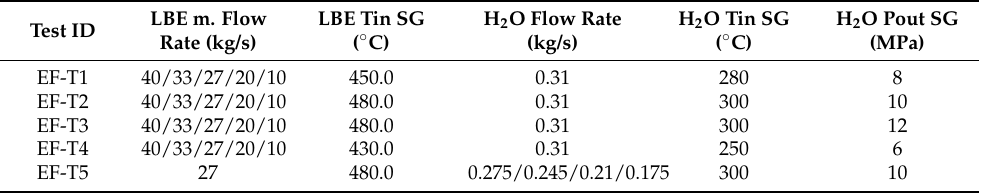
Table 1. Designed boundary conditions for the EUROfusion